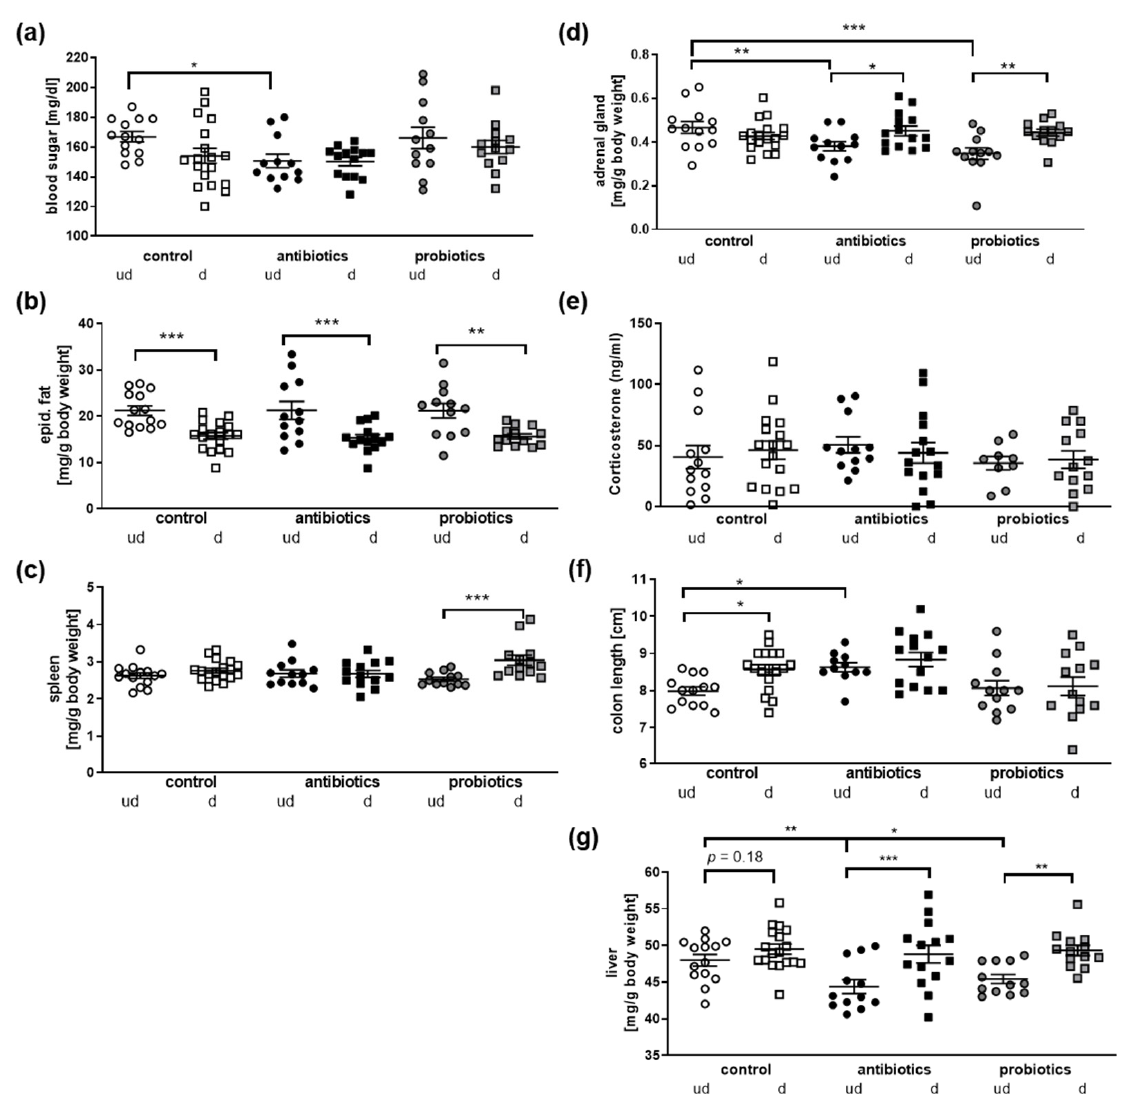
Figure 3. Physiological parameters in mice after CSDS. Mice that underwent antibiotics or probiotics treatment or served as controls derived from defeated (d) or undefeated (ud) groups were euthanized after assessing social interaction. ( a ) Blood sugar levels were measured using truncal blood directly upon euthanization. ( b ) Epididymal fat deposits were extracted and weighed. Data are shown after normalization to body weight. ( c ) Spleen was dissected and relative weight calculated. ( d ) Adrenal glands were extracted and weight assessed. Shown are values normalized to body weight. ( e ) Corticosterone serum levels were measured by HPLC method. ( f ) Colon length was measured directly during dissection, and liver weight assessed and normalized to body weight ( g ). All values present mean with SEM. All values were included if not identified as outliers (Q of 1%). Statistical analysis was performed by one-way ANOVA with Fisher’s LSD test (n = 10–18 for all groups).